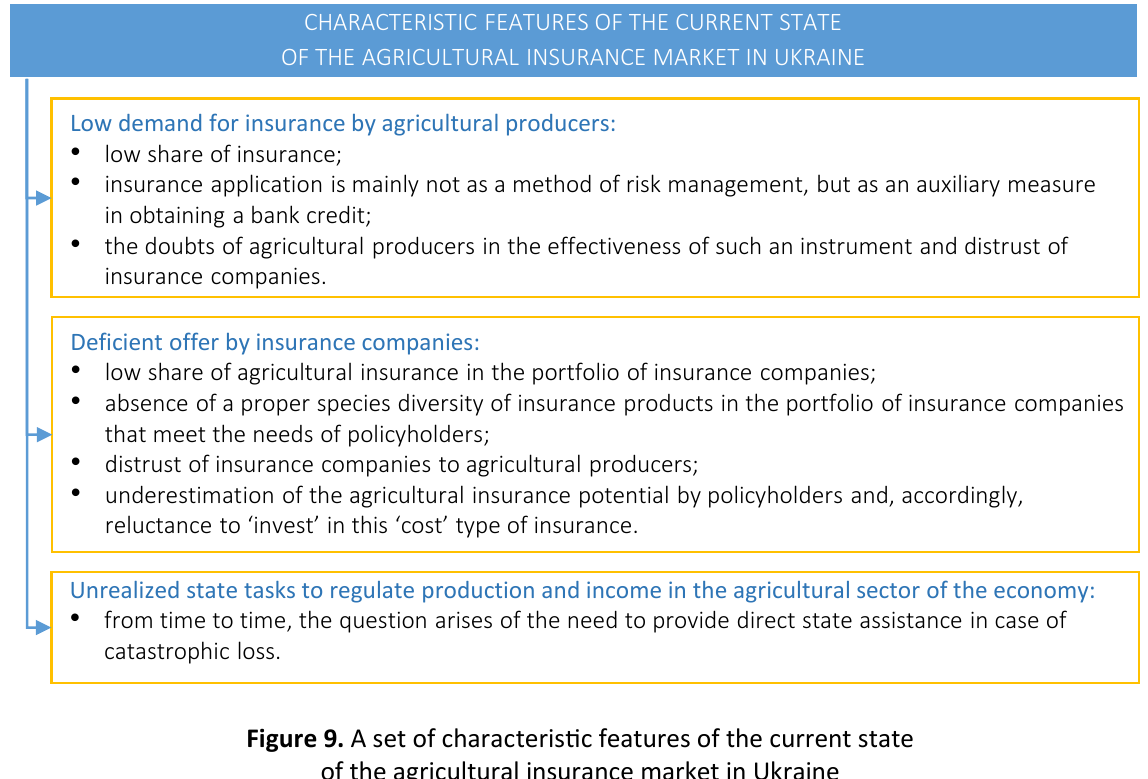
Figure 9. A set of characteristic features of the current state of the agricultural insurance market in